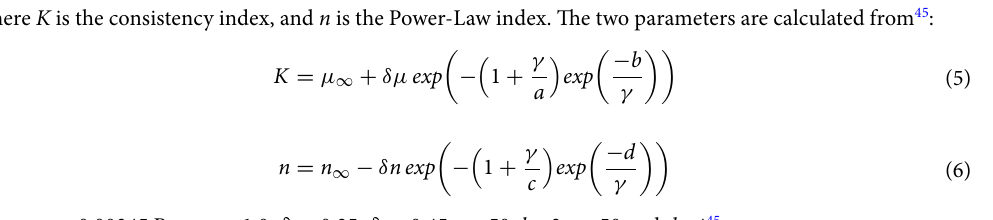
(Table 2). Numerous non-Newtonian models have been used throughout literature for simulating blood flow: Carreau 42 ,